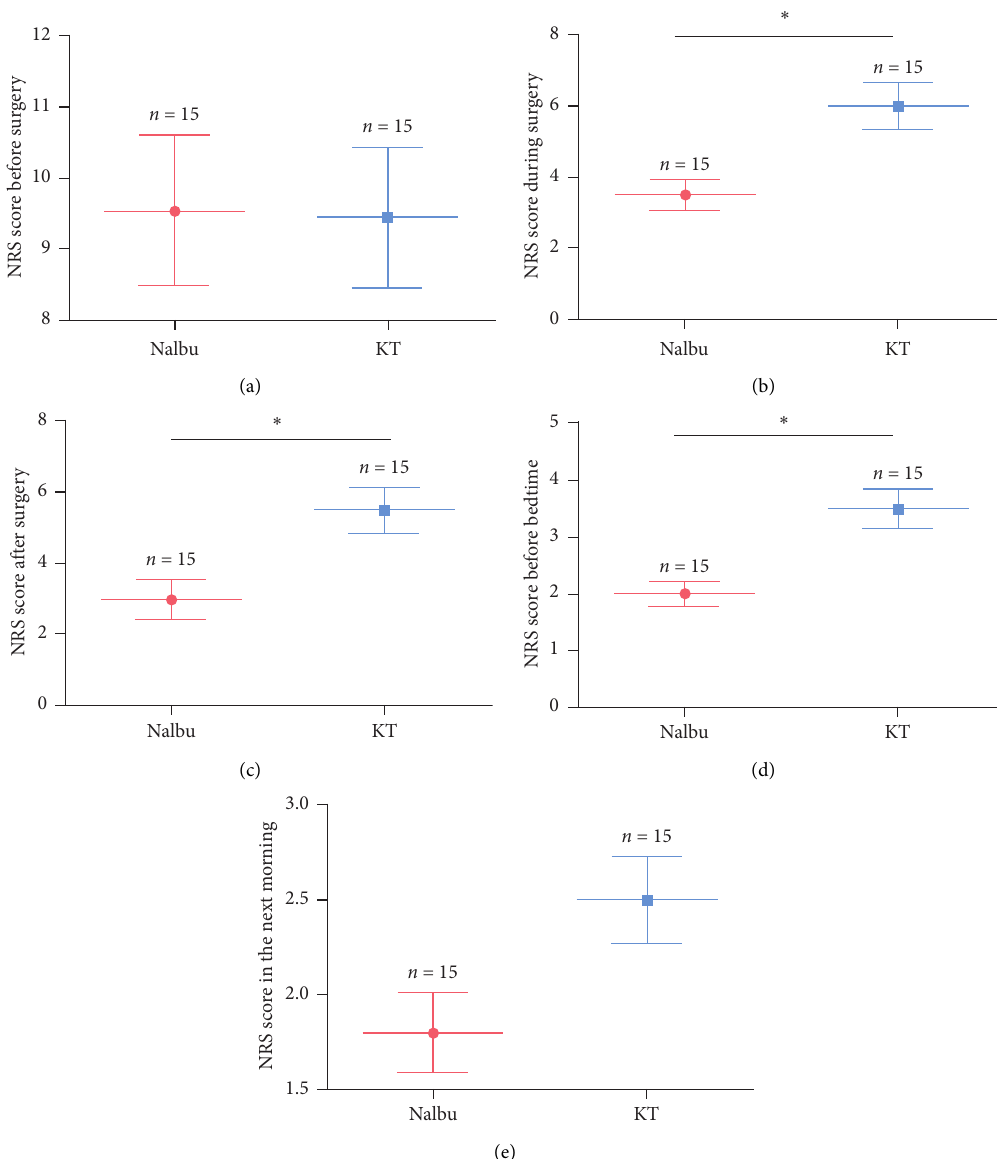
Figure 4: The NRS scores of patients between two groups. (a) NRS score before surgery; (b) NRS score during surgery; (c) NRS score after surgery; (d) NRS score before bedtime; (e) NRS score in the next morning. NRS, numerical rating scale; Nalbu, nalbuphine; KT, ketorolac tromethamine. n � 15 for each group, ∗ P < 0 . 05.